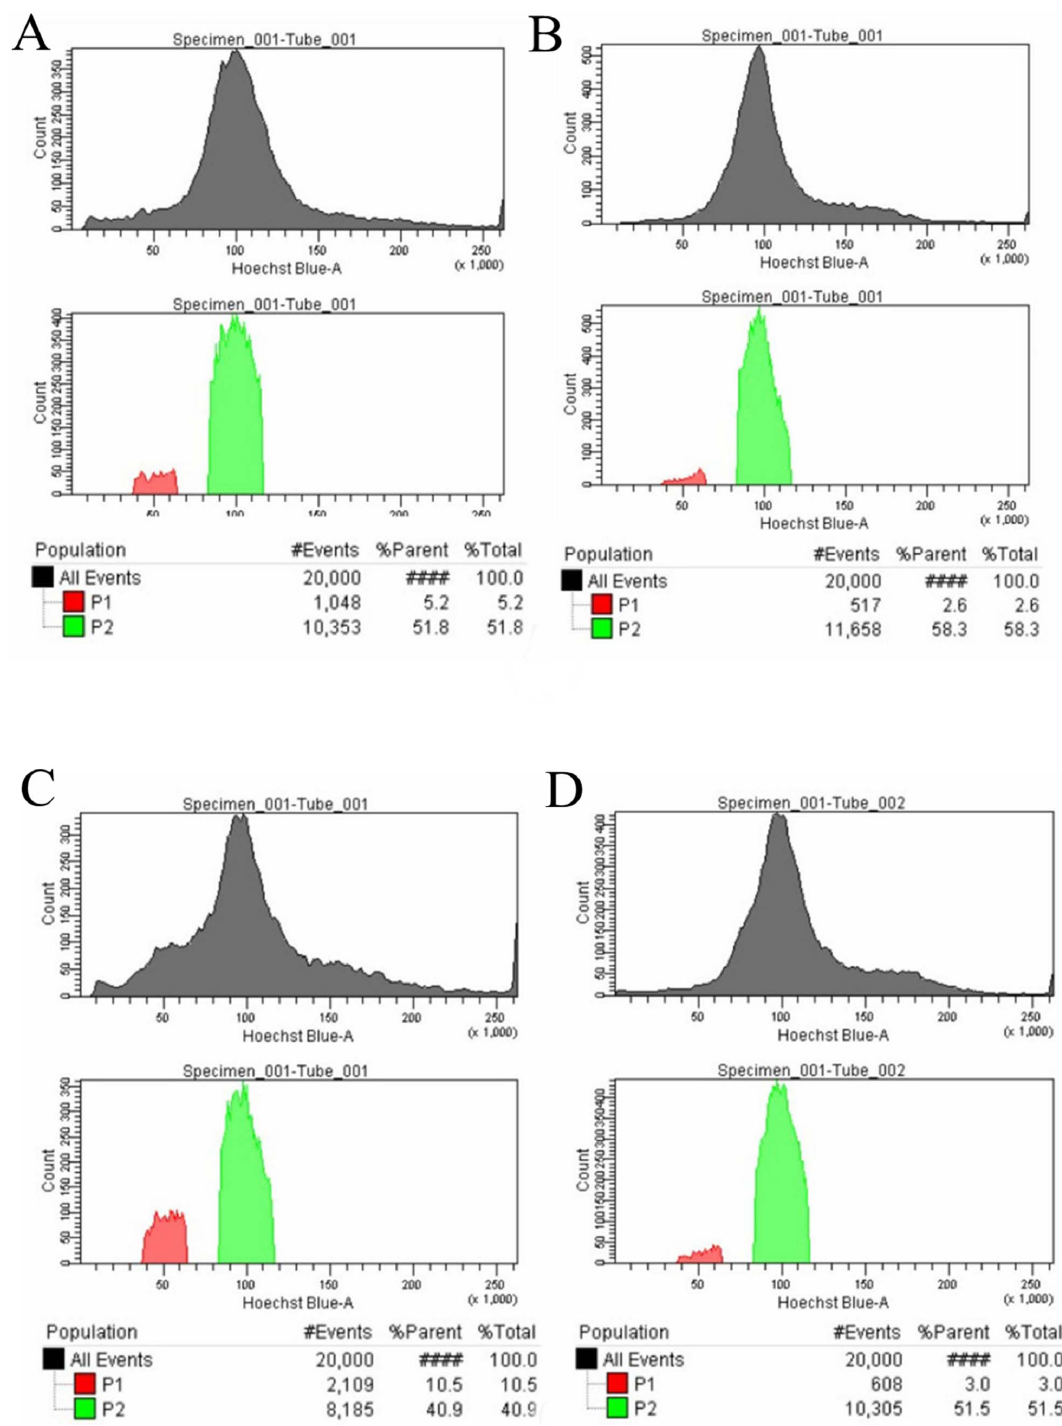
Figure 4. The flow cytometry sorting results of PA embryo-derived fetal fibroblasts. (A and B) The sorting of cell line pPEF3-2 and the corresponding control fPEF5. (C and D) The sorting of cell line pPEF3-5 and its corresponding control fPEF6. The results show that PA cell lines indeed contain more cells with decreased (less than diploid) DNA content. the abnormal development of the porcine PA fetus or find candidate genes related to abnormal development. Diploid PA fetal fibroblasts may be candidate cells for discovery of unknown paternally imprinted genes.